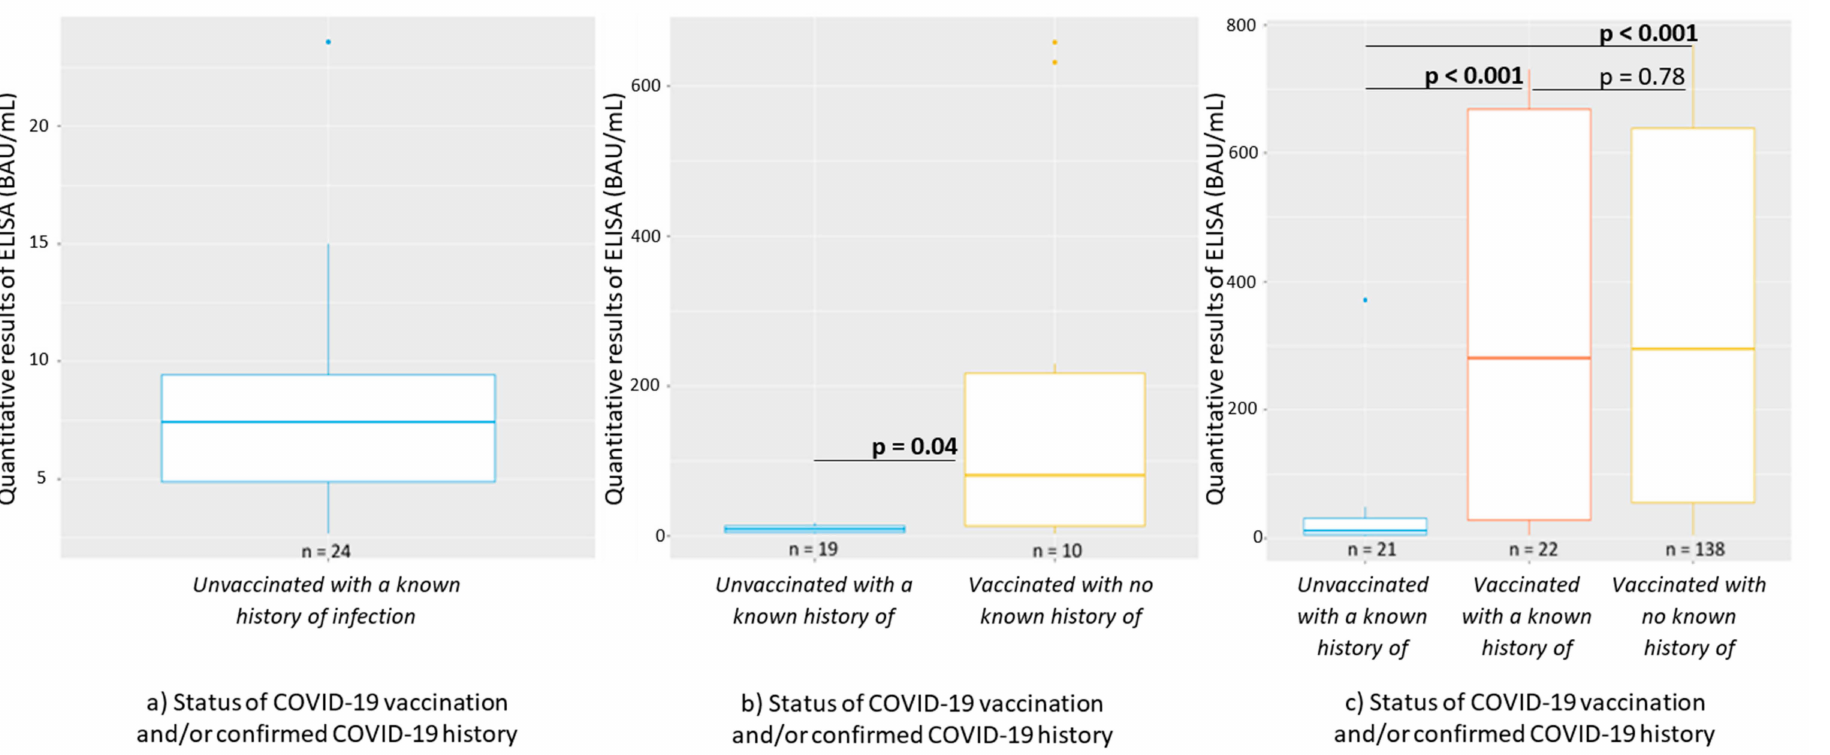
Figure 3. Levels of the IgG antibodies (BAU/mL) against the SARS-CoV-2 S protein by participants’ immune status according to ( a ) phase 1; ( b ) phase 2; ( c ) phase 3 of the study. The line in the center of the box depicts the median; the lower and upper hinges correspond to the first and third quartiles; and the distance between the first and third quartiles corresponds to the interquartile